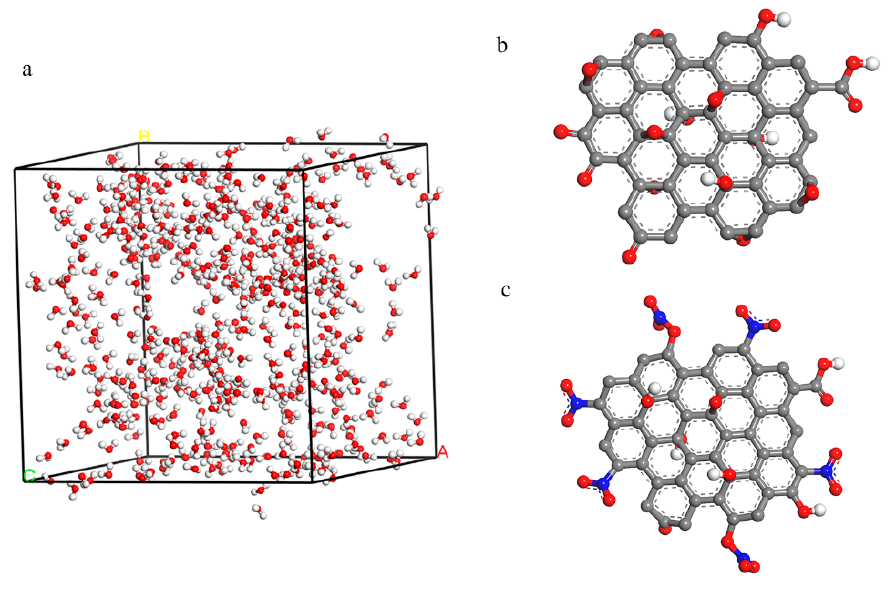
Figure 2. ( a ) The 500 water models inside the cell with a size of 33.44 × 33.44 × 33.44 Å 3 ; ( b ) the model of GO; ( c ) the model of nitrated graphene oxide (NGO).